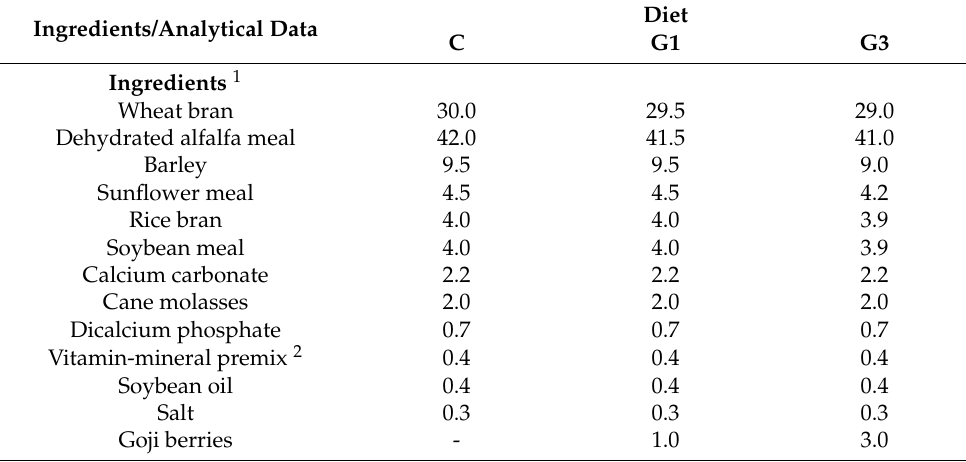
Table 1. Formulation and chemical composition (as fed) of control (C) and experimental diets supplemented with 1% (G1) and 3% (G3) Goji